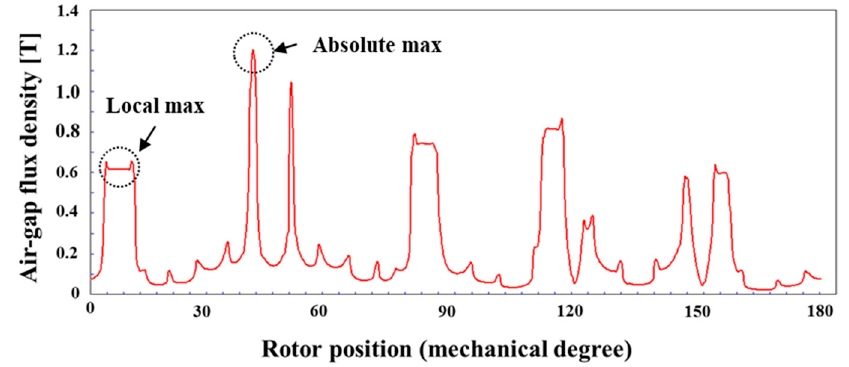
Figure 13. Air-gap flux density distribution due only to the excitation of the NI HTS field coils when the rotor position is on the d-axis.